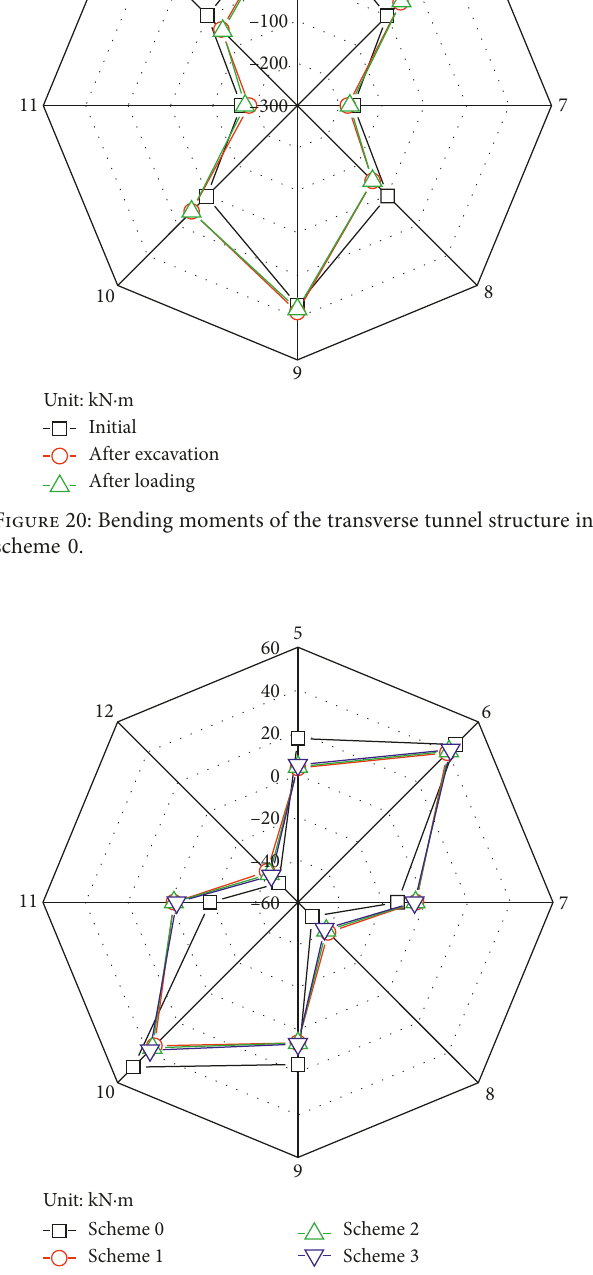
Figure 21: Additional bending moments of the tunnel structure after the foundation pit excavation.